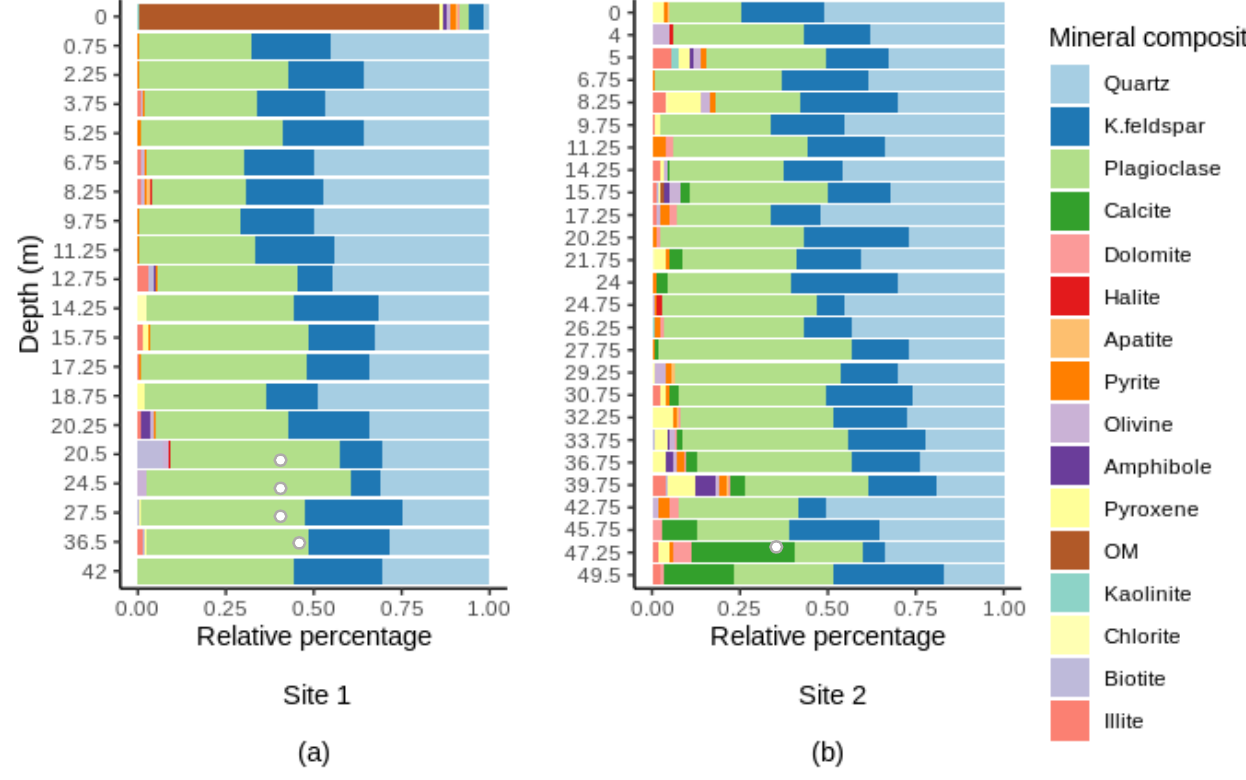
Figure 4. Mineral composition along depth at site 1 ( a ) and at site 2 ( b ). OM, organic matter. Bedrock samples are indicated by hollow symbols. For full details on the mineralogical composition, see Supplementary Tables S4 and S5.